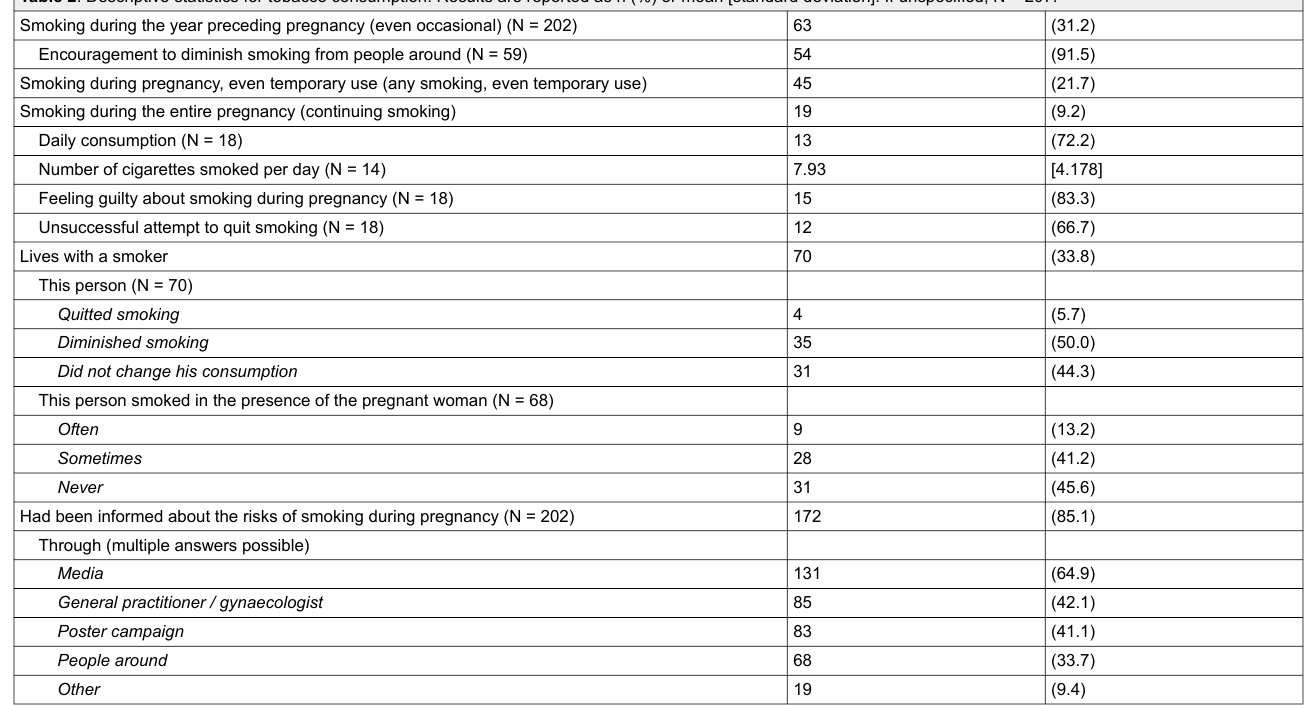
Table 2 : Descriptive statistics for tobacco consumption. Results are reported as n (%) or mean [standard deviation]. If unspecified, N = 207. Smoking during the year preceding pregnancy (even occasional) (N =